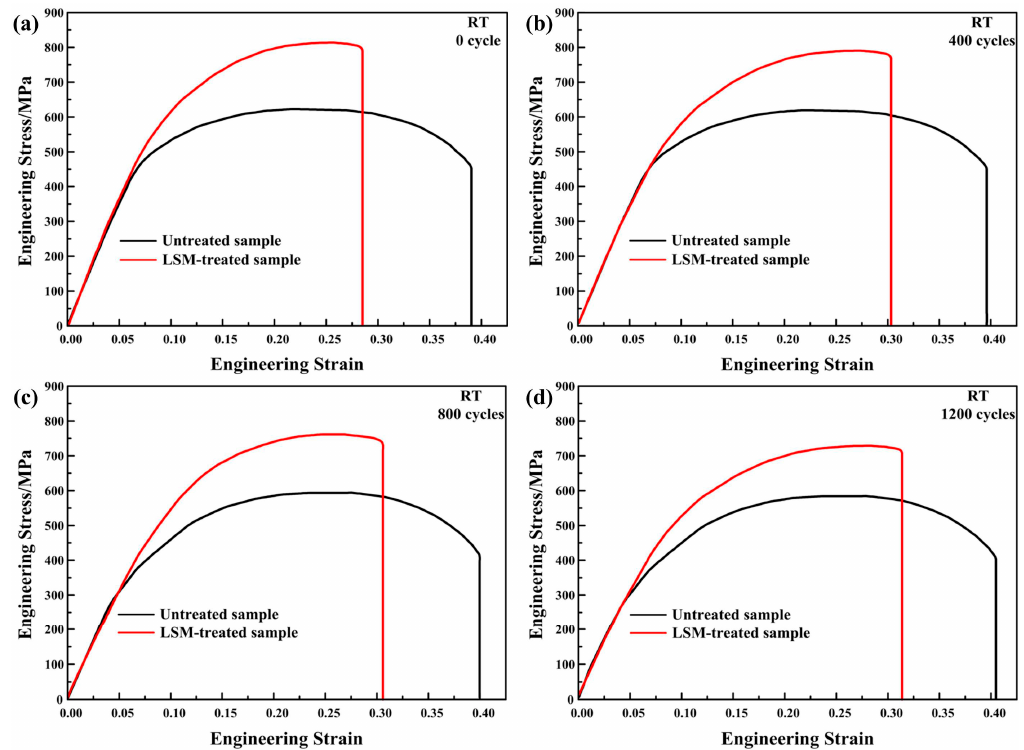
Figure 9. Stress-strain curves of LSM-treated specimen and untreated specimen at room temperature (RT) and for thermal fatigue cycles equal to ( a ) 0 cycle, ( b ) 400 cycles, ( c ) 800 cycles, and ( d ) 1200cycles.